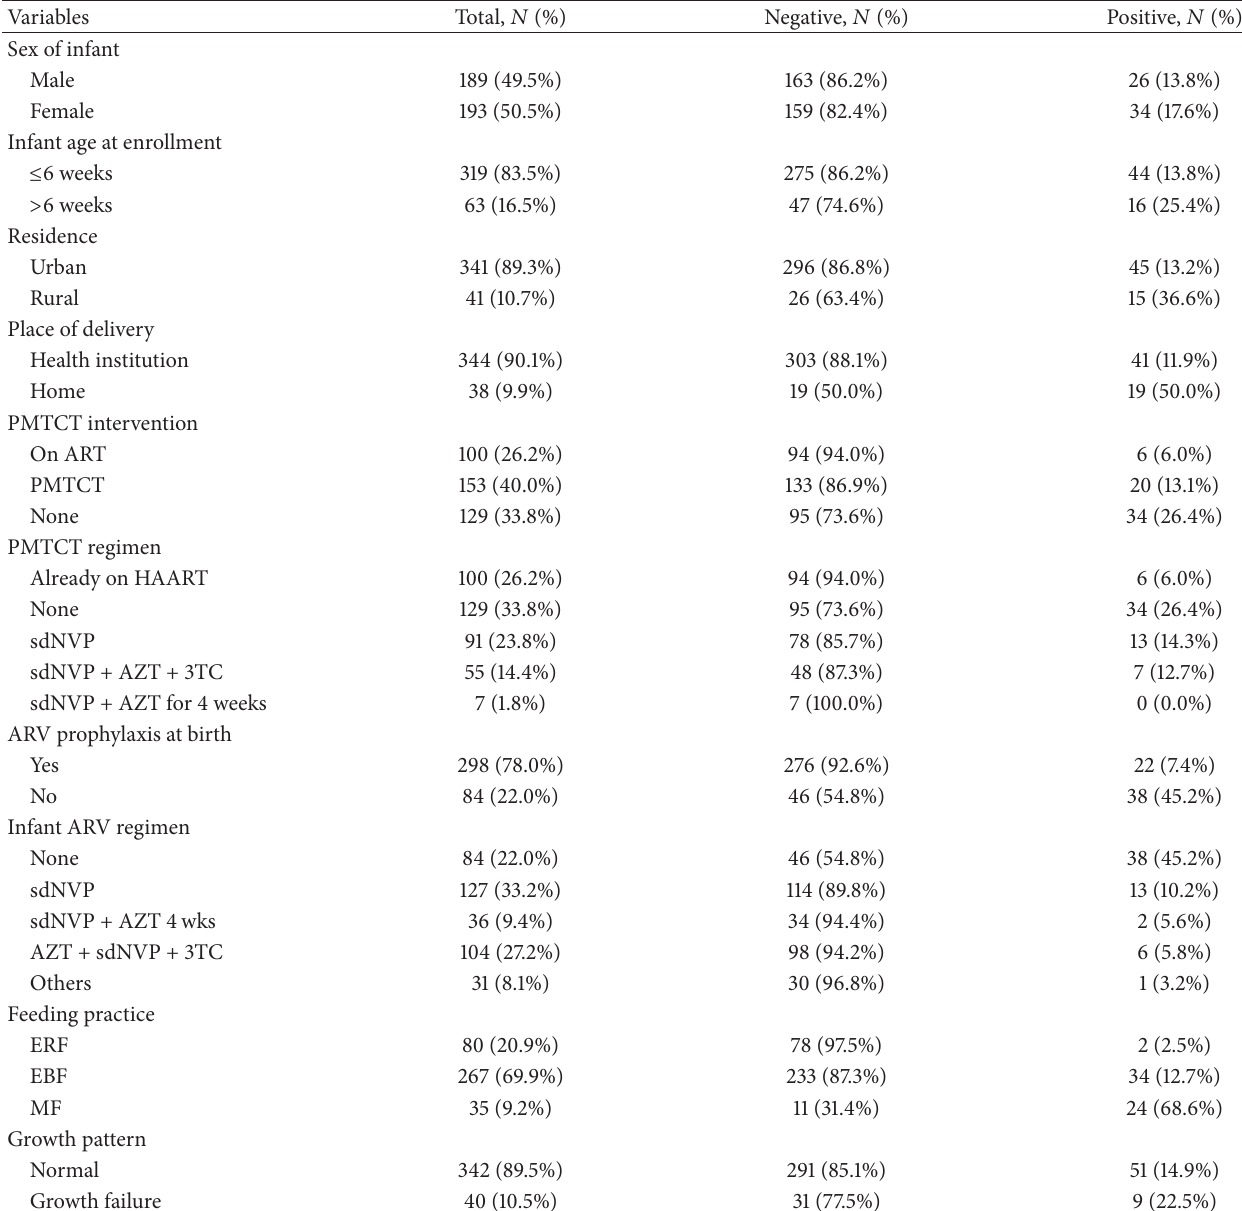
Table 1: Sociodemographic and clinical characteristics of HIV-exposed infants on follow-up care in Dire Dawa, Ethiopia, September 2014.